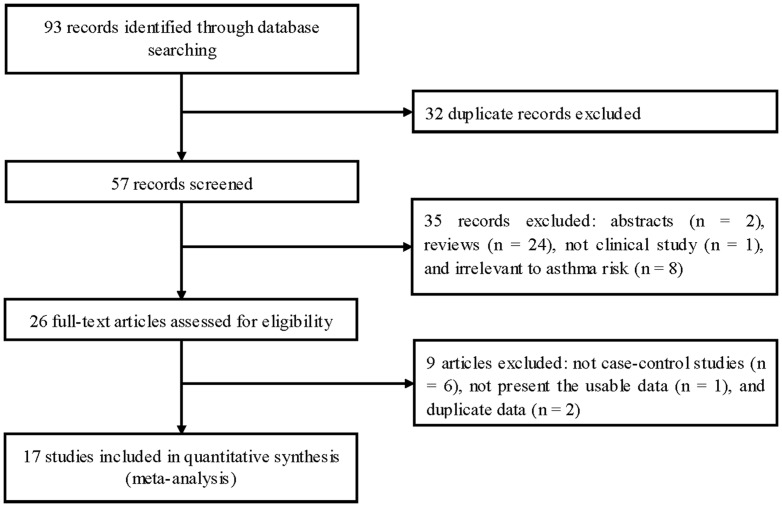
Flow of study identification, inclusion, and exclusion.